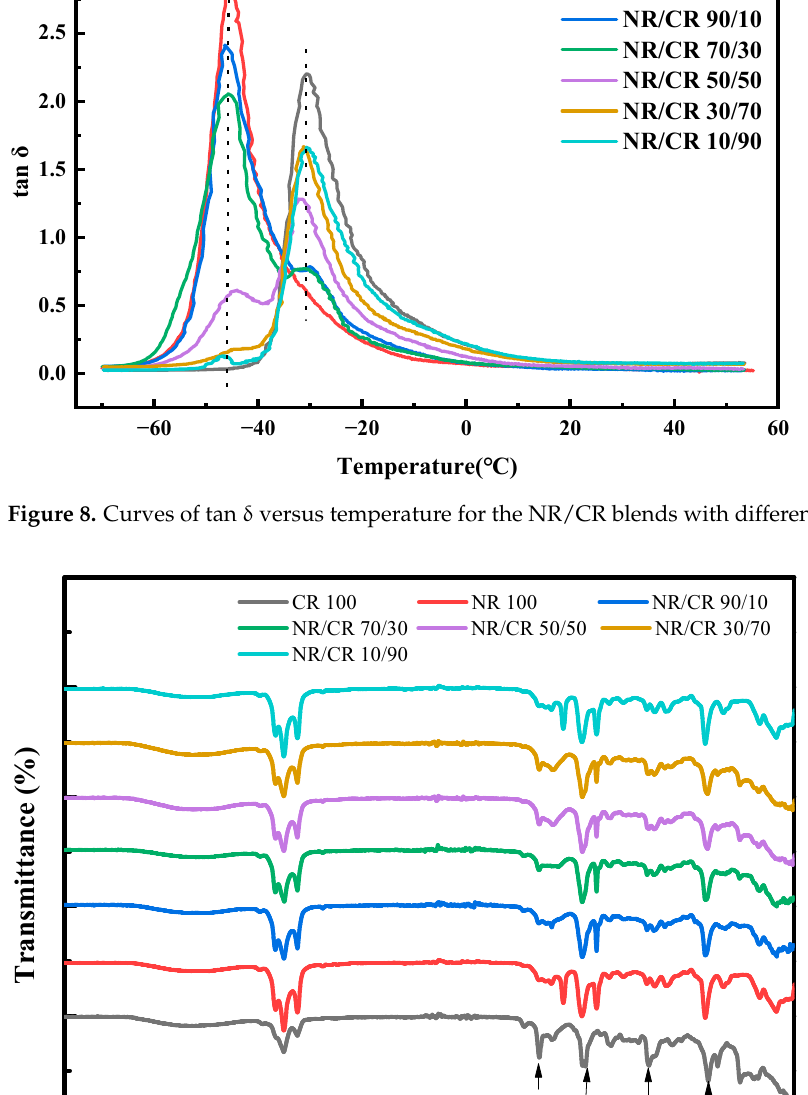
12 of 15 Figure 7. Morphologies ( a ) and iso-surface ( b ) of the NR/CR blends with different mass ratios. (In Figure 7a, red represents NR particles, and green represents CR particles. In Figure 7b, red repre- sents the CR iso-surface, and gray represents the NR iso-surface.) 3.5. DMA Curves of the NR/CR Blends Figure 8 shows the curves of tan δ versus temperature for the NR/CR blends with different mass ratios. It can be seen that the tan δ peaks of pure NR and CR can be found at 46 °C and 31 °C, respectively. In other words, the glass transition temperatures of NR and CR are 46 °C and 31 °C, respectively. The NR/CR blends with different mass ratios show two peaks, and the temperature of the two tan δ peaks are almost at the positions of the glass transition temperature of pure NR and pure CR. Therefore, there are two tan δ peaks corresponding to the glass transition temperature of pure NR and CR in the NR/CR blends, indicating that the NR/CR blends with different mass ratios have poor compatibility. Nevertheless, the two tan δ peaks shift to each other in some cases, which